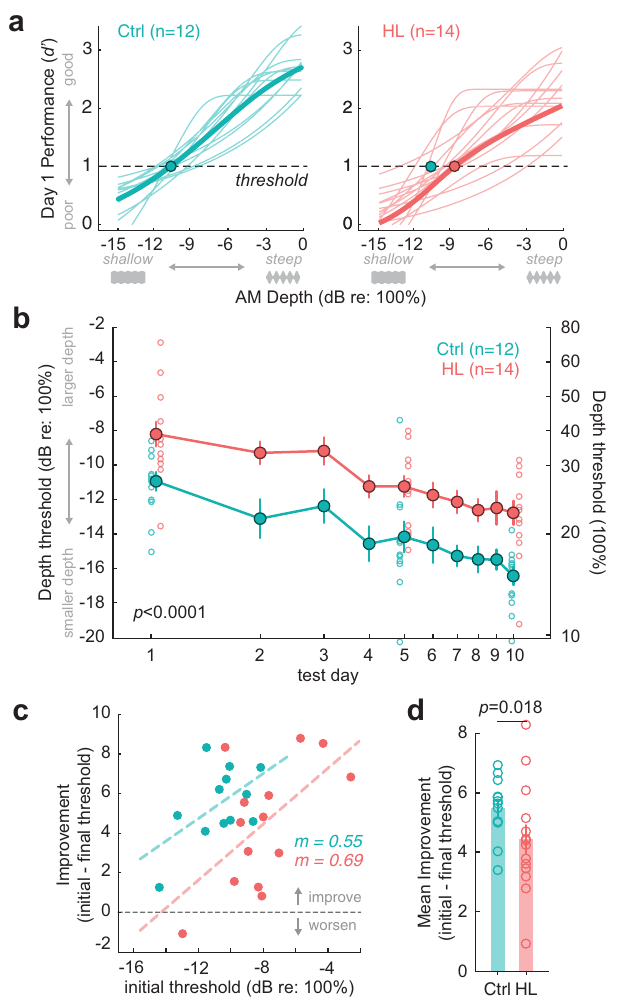
whether the perceptual de fi cits that we observed were due, in part, to elevated stress associated with earplugs, we obtained cortisol levels in each animal (Supplementary Fig. 2) at fi ve timepoints across development (P35, P54, P65, P90, and P102). We found no signi fi cant effect of hearing status on cortisol levels across age (Supplementary Fig. 2a; two-way repeated measures ANOVA: F (1,11) = 0.02, p = 0.91). In addition, we found no signi fi cant correlations between cortisol level at any developmental age with perceptual performance on the fi rst day of testing (Pearson ’ s r = − 0.4 – 0.3; p-values of linear regression = − 0.2 – 0.7), validat- ing that the de fi cits observed were not due to elevated early life signi fi cant differences in the rate at which males or females stress (Supplementary Fig. 2b). learned the task procedure (Supplementary Fig. 1a; mixed- model ANOVA: F (1,3) = 0.32, p = 0.61). Further, males and females required a comparable number of Warn trials to reach criterion for training performance ( d ′ ≥ 1.5; Supplementary Fig. 1b mixed-model ANOVA: F (1,22) = 0.001, p = 0.97). Tukey ’ s perceptual de fi cits observed following adolescent hearing loss was test for multiple comparisons revealed no signi fi cant effect of speci fi cally due to the developmental period, or whether the long sex within each group (control male, female: p = 0.99; HL duration of deprivation itself caused the effect. To test this, we male, female: p = 0.99). Males and females also achieved induced the same duration of HL (80 days) beginning in adult- comparable performance (average d ′ ) during the last 20 trials of hood ( ≥ P102) in a separate set of animals (Adult controls, n = 8; procedural training (Supplementary Fig. 1c; mixed-model Adult-onset HL, n = 8). Following 80 days of HL, earplugs were ANOVA: F (1,22) = 0.37, p = 0.55). Tukey ’ s test for multiple removed and animals experienced the same duration of recovery comparisons revealed no signi fi cant effect of sex within each (3 weeks) prior to training and testing on the AM depth detection group (control male, female: p = 0.86; HL male, female: p = 0.99). task. Adult controls and adult-onset HL animals learned the task Therefore, we did not fi nd sex-speci fi c differences in procedural procedure at the same rate (Fig. 4a). A two-way mixed-model training on the behavioral task. Next, we examined whether there ANOVA revealed a signi fi cant effect of trial number on perfor- were male and female differences in perceptual thresholds across mance ( F (159,318) = 3.18, p < 0.001), no effect of earplug experi- the 10 days of psychometric testing. A two-way mixed-model ence ( F (1,2) = 0.002, p = 0.97), and no interaction between the two ANOVA followed by a Tukey ’ s test for multiple comparisons variables ( F (159, 318) = 0.96, p = 0.62). Both groups took the same revealed no signi fi cant effects of sex for control ( p = 0.81) or HL number of warn trials to reach criterion for training performance animals ( p = 0.78). See Supplementary Fig. 1d for depth detection (Fig. 4b; F (1,14) = 0.0013, p = 0.97), and both groups achieved thresholds on the fi nal day of testing for male and female Control comparable performance ( d ′ ) on the last 20 trials of procedural and HL animals. training prior to psychometric testing (Fig. 4c; F (1,14) = 0.61, Chronic stress during adolescence can have adverse effects on p = 0.45). central nervous system structure and function 30 . To determine NATURE COMMUNICATIONS| (2022) 13:2872